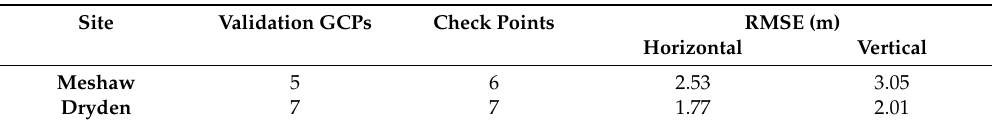
Table 2. Positional errors (RMSE) in SfM point clouds. GCPs for Dryden were measured using GNSS while those for Meshaw were extracted from the LiDAR DSM.